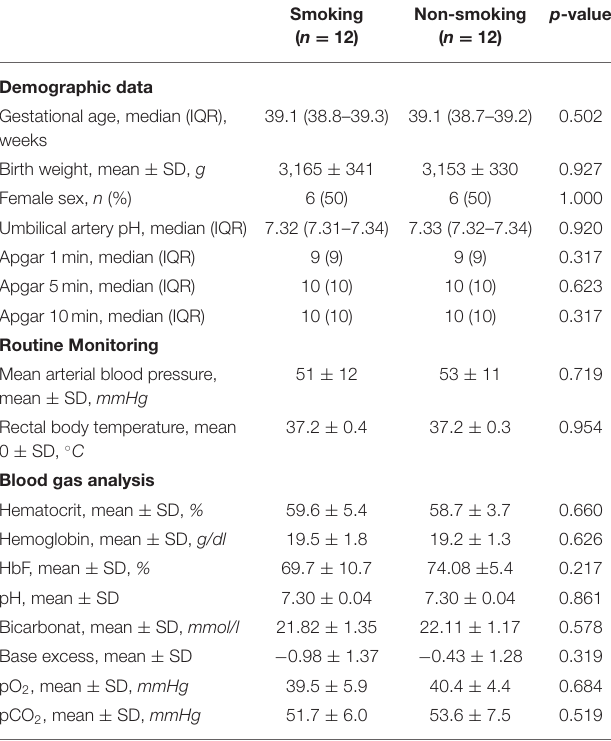
TABLE 1 | Characteristics of term neonates from mothers who had smoked during pregnancy and in term neonates from mothers who had not smoked during pregnancy (smoking group and non-smoking group).